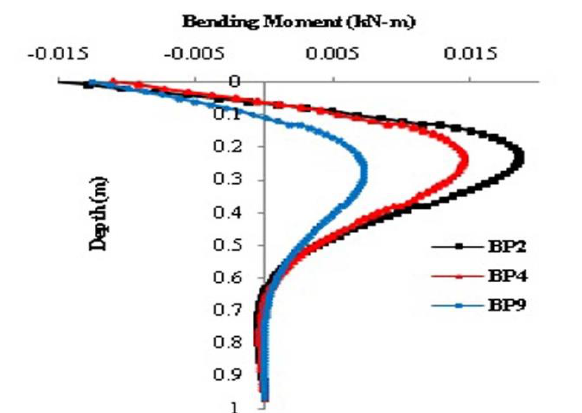
Fig. 14. Predicted different pile group bending moments at 3D pile spacing of bamboo pipe piles in loose layer in- between dense layers for slenderness ratio=38.